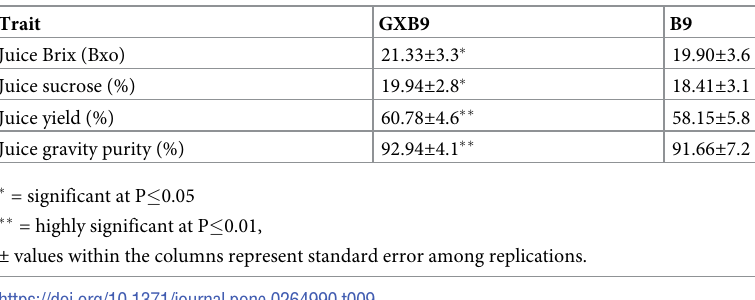
Table 9. Cane juice quality traits in GXB9 and B9.